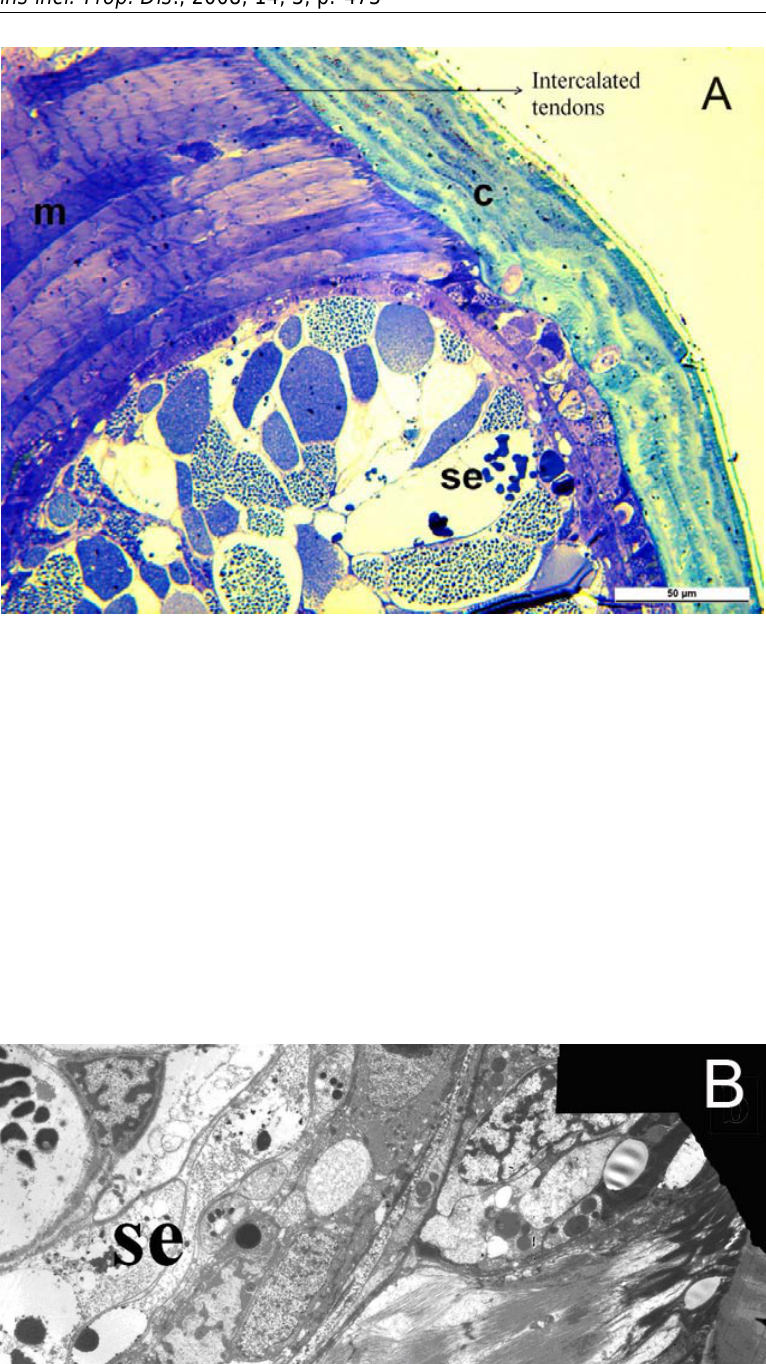
N. Yigit and M. Benli THE VENOM GLAND OF THE SCORPION SPECIES Euscorpius mingrelicus (SCORPIONES: EUSCORPIIDAE): MORPHOLOGICAL AND ULTRASTRUCTURAL CHARACTERIZATION.